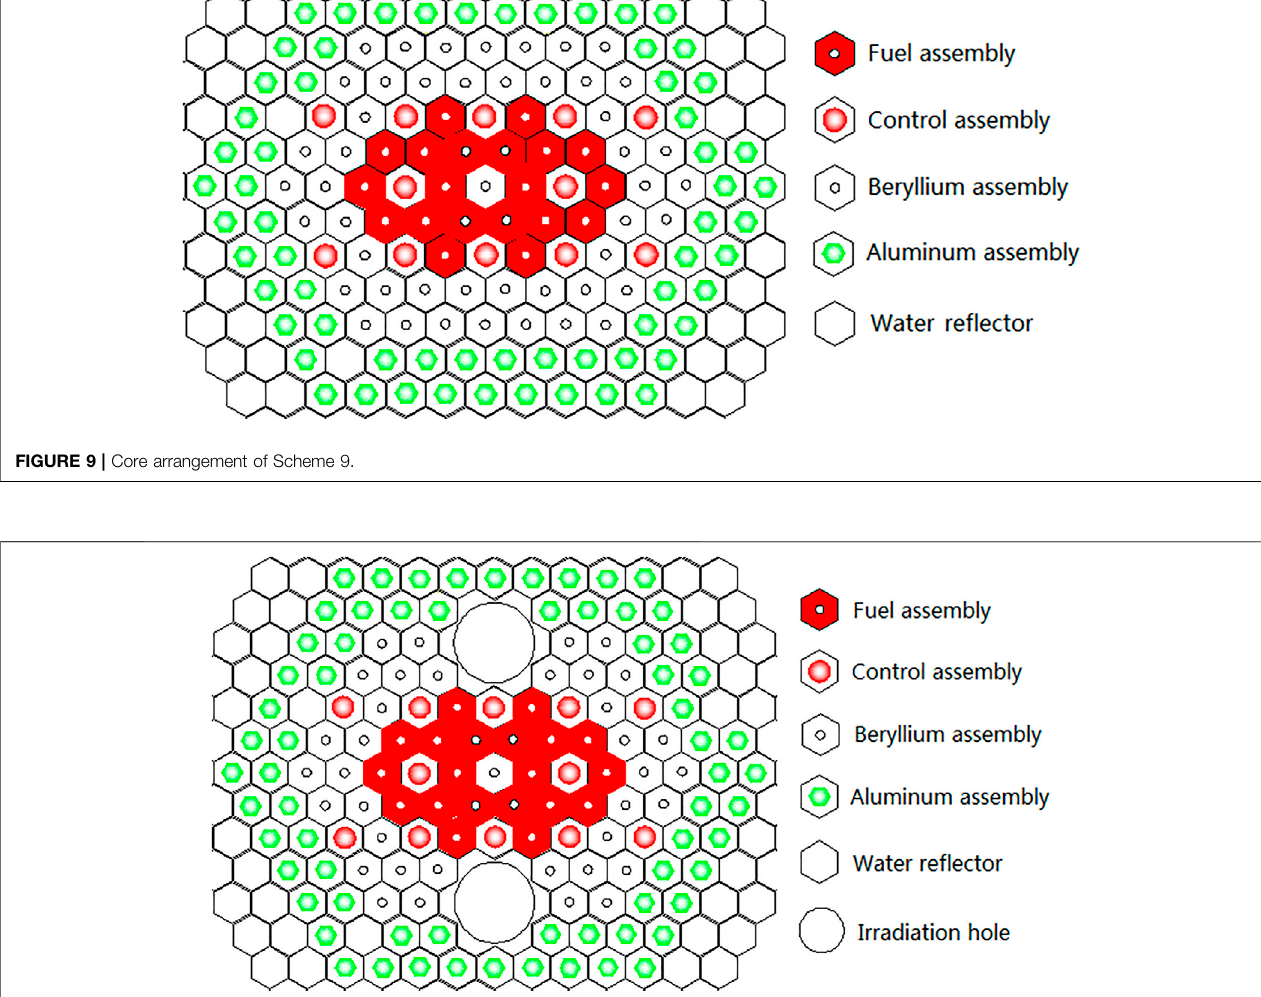
FIGURE 10 | Core arrangement of Scheme 10-1 and Scheme